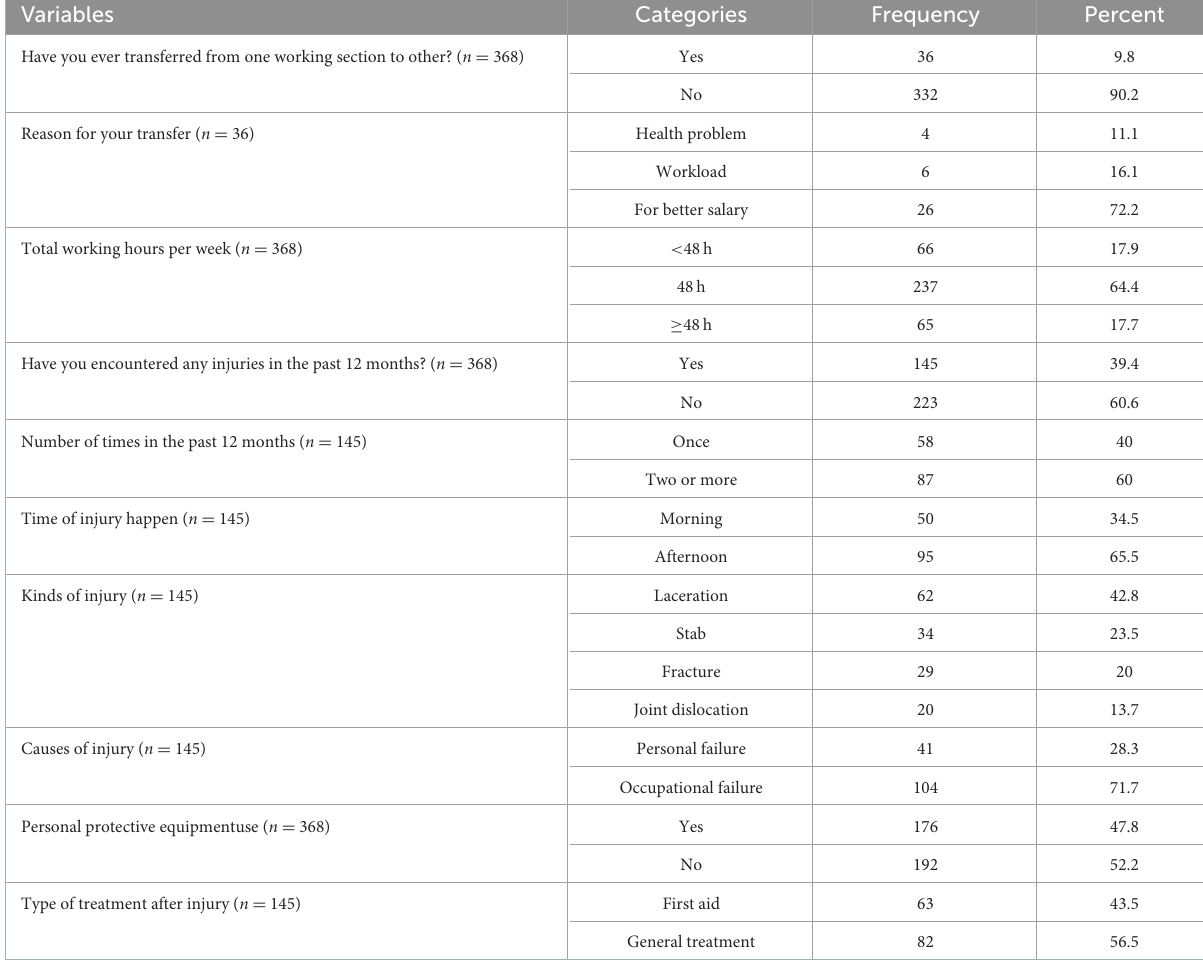
TABLE 2 Description of the occupational injury-related characteristics among Bure industry park construction workers in Northwest Ethiopia.